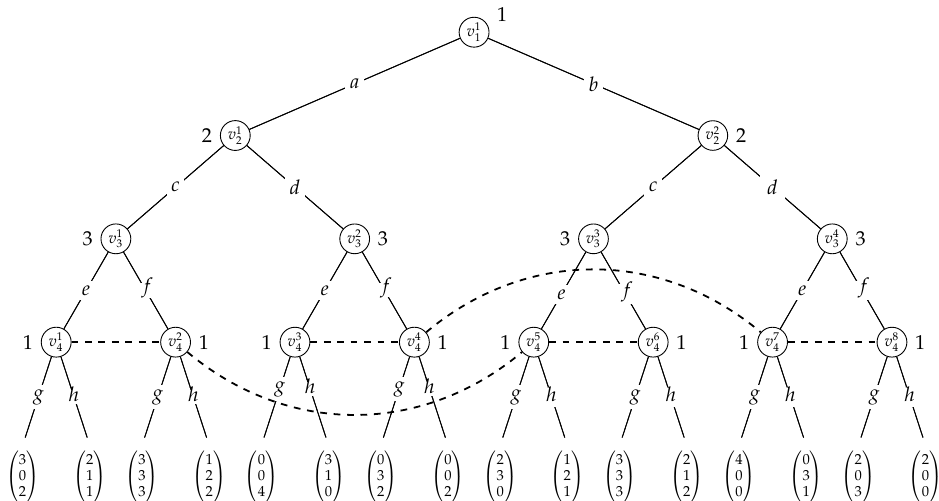
Figure 6. Extensive-form game of imperfect information representing the partial order game in Figure 3 assuming topological order ( v 1 , v 2 , v 3 , v 4 ) . Here, for instance, v 1 The dashed lines connecting vertices indicate the information